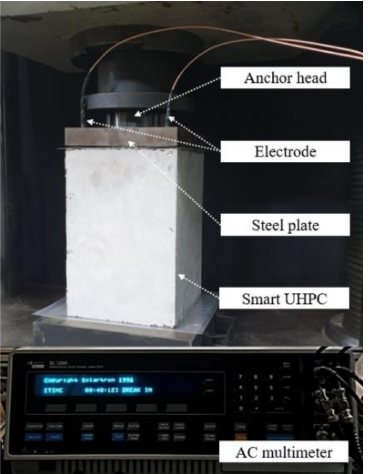
Figure 7. Test setup for AC electrical resistivity measurement.